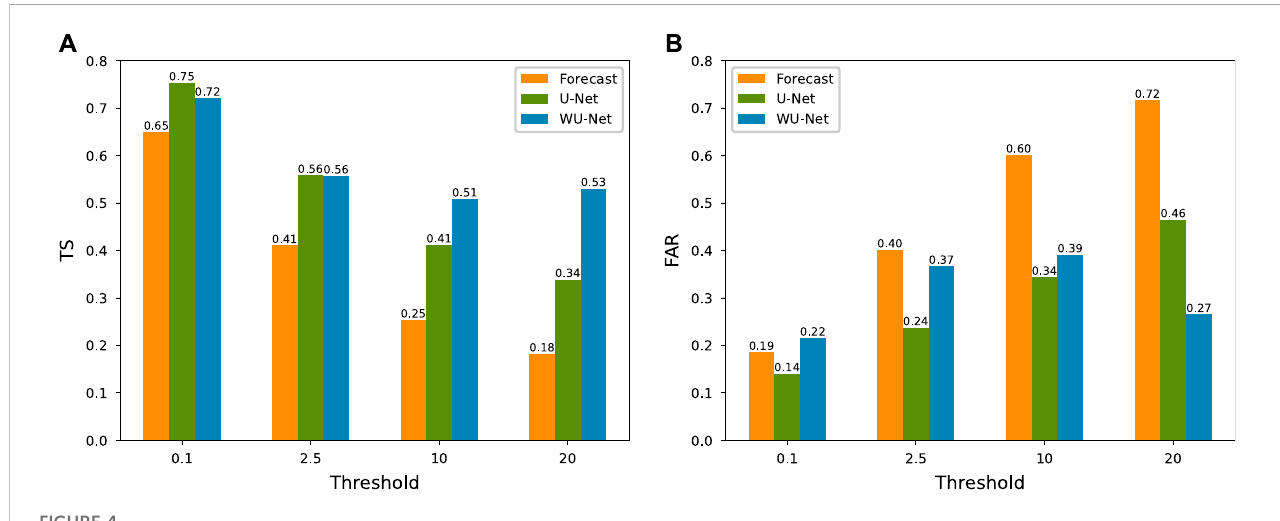
FIGURE 4 (A) TS and (B) FAR of the ECMWF-IFS, U-Net and WU-Net, respectively, under the thresholds of 0.1, 2.5, 10, and 20 mm. The orange, green, and blue represent the ECMWF-IFS, U-Net and WU-Net,